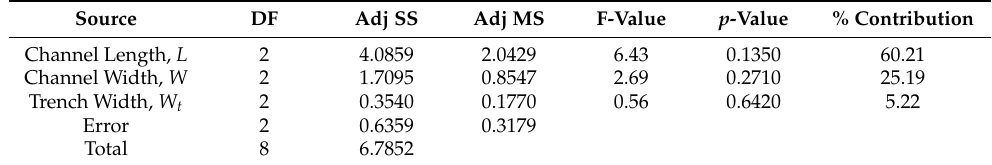
Table 9. ANOVA results for γ .